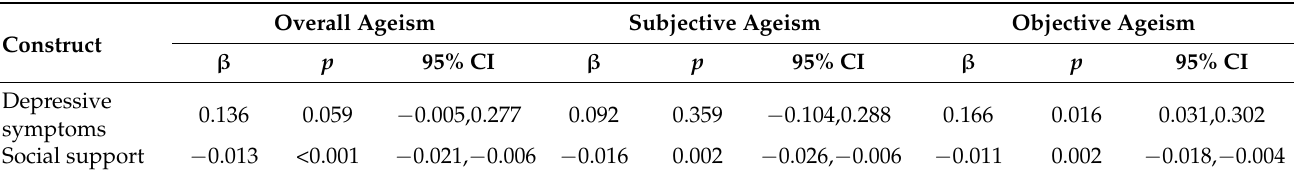
Table 2. Bivariate associations with